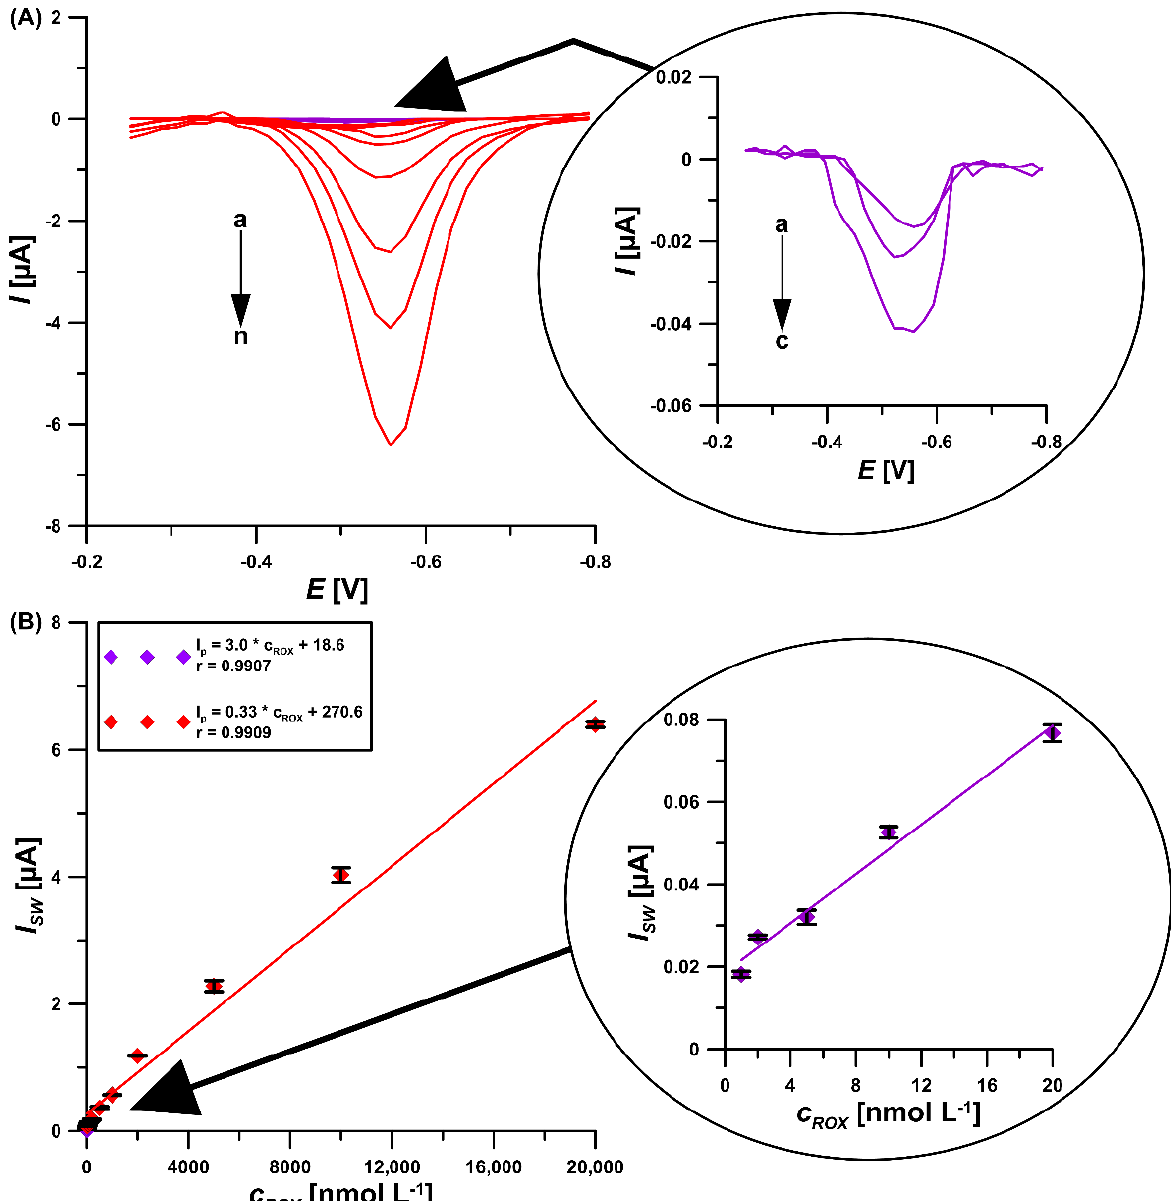
Figure 9. ( A ) SWAdSV curves at the GCE/CTAB in 0.075 M NaAc–HAc buffer of pH = 5.6 containing 40 mg/L CTAB and increasing concentrations of ROX (a → m, 0.001, 0.002, 0.005, 0.01, 0.02, 0.05, 0.1, 0.2, 0.5, 1, 2, 5, 10, 20 µM); ( B ) Linear calibration plots of ROX. The procedure parameters: t = 90 s, f = 350 Hz, E SW = 50 mV and ∆ E = 18 mV. The standard deviation was calculated for n = 3.